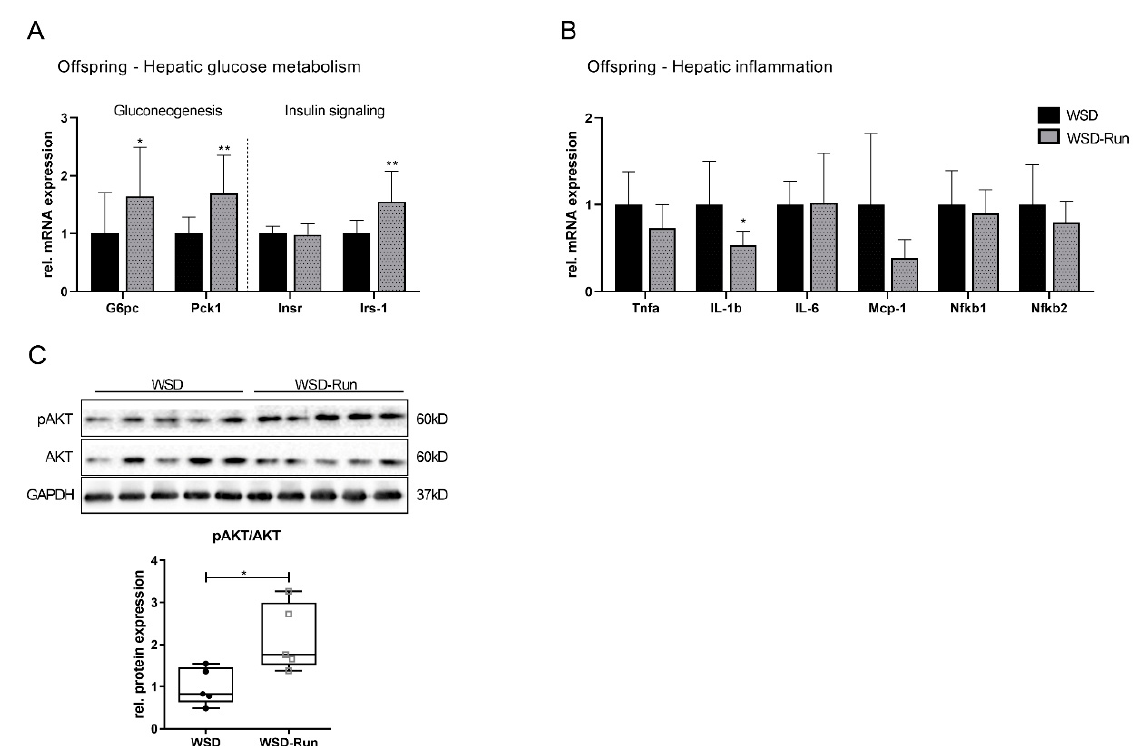
Figure 6. Impact of maternal exercise on offspring hepatic glucose metabolism and hepatic inflammation in early life (P21). ( A ) Assessment of regulators of hepatic gluconeogenesis ( G6pc , Pck1 ) and hepatocellular insulin signaling ( Insr , Irs-1 ) by qPCR (WSD group (n = 10), WSD-Run (n = 10)). ( B ) Determination of regulators of hepatic inflammation ( Tnfa , Il-1b , Il-6, Mcp-1 , Nfkb1 , Nfkb2 ) by qPCR (WSD group (n = 10), WSD-Run (n = 10)). ( C ) Representative immunoblot of (p)AKT, as marker of hepatic insulin signaling (WSD group (n = 5), WSD-group (n = 5)). GAPDH served as the loading control. Data